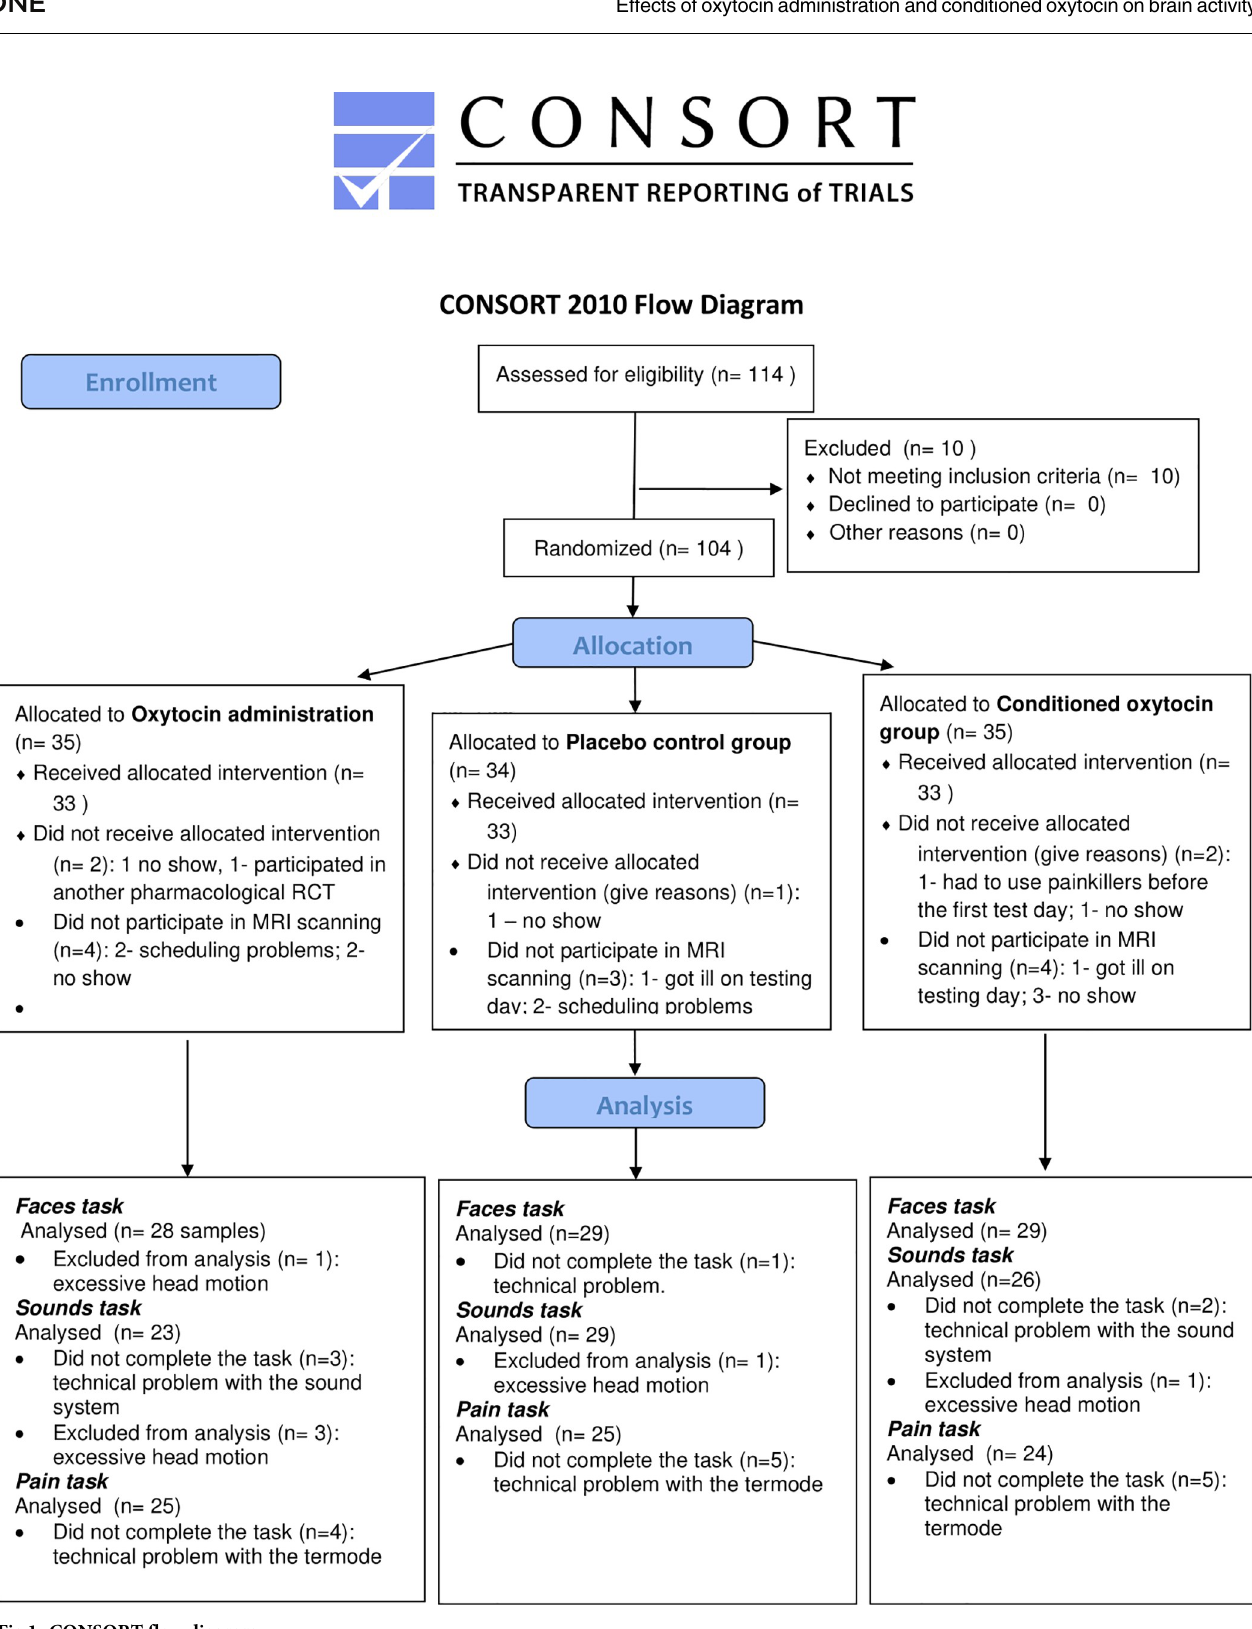
PLOS ONE | https://doi.org/10.1371/journal.pone.0229692 March 19,